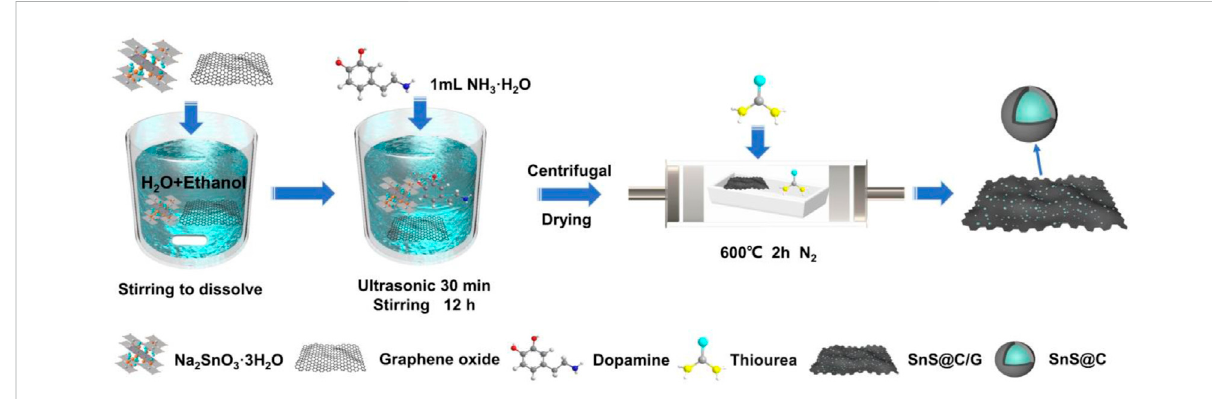
FIGURE 1 Schematic diagram of the preparation process of SnS@C/G